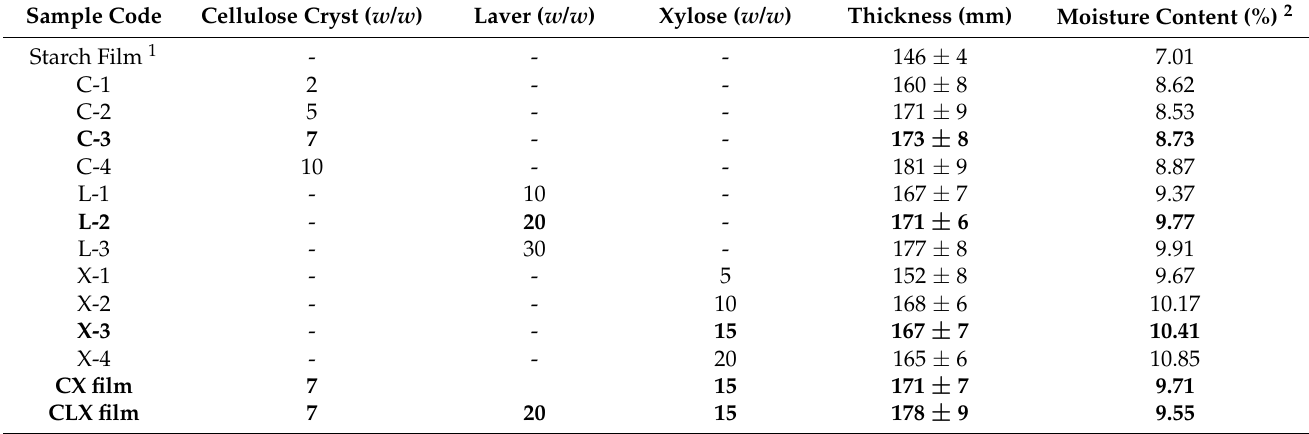
Table 1. Sample code, formulations, as well as film thickness and moisture content.